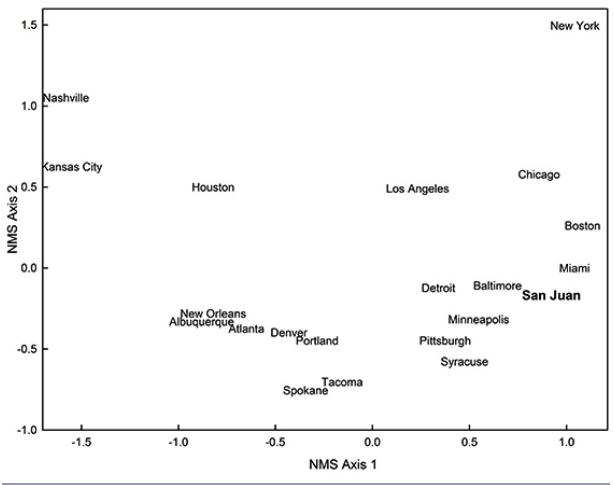
Fig. 5. Nonmetric multidimensional scaling ordination of city green feature similarities generated using the Sørensen distance (McCune and Mefford 2006). Six variables were included in the analysis: land area, percent green cover, percent impervious cover, area of green cover, population density, and per capita green space (Table 3). The city of San Juan is indicated in boldface